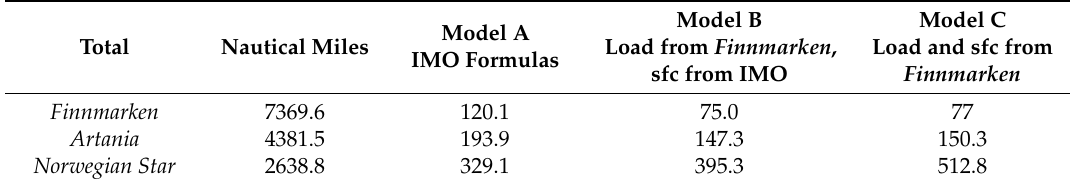
Table 15. Estimates for kg pr nautical mile for Finnmarken , Artania , and Norwegian Star with different models.